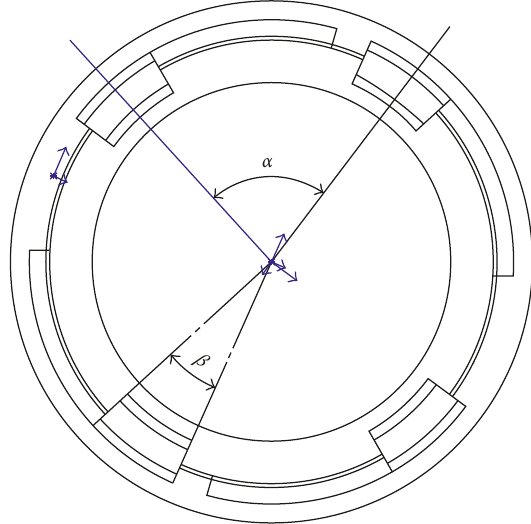
Figure 4: Diagrammatic sketch of angles α and β .